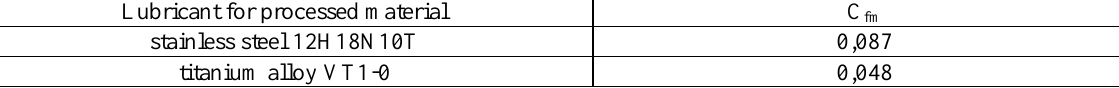
The value of the coefficients C fm and xm for various processed